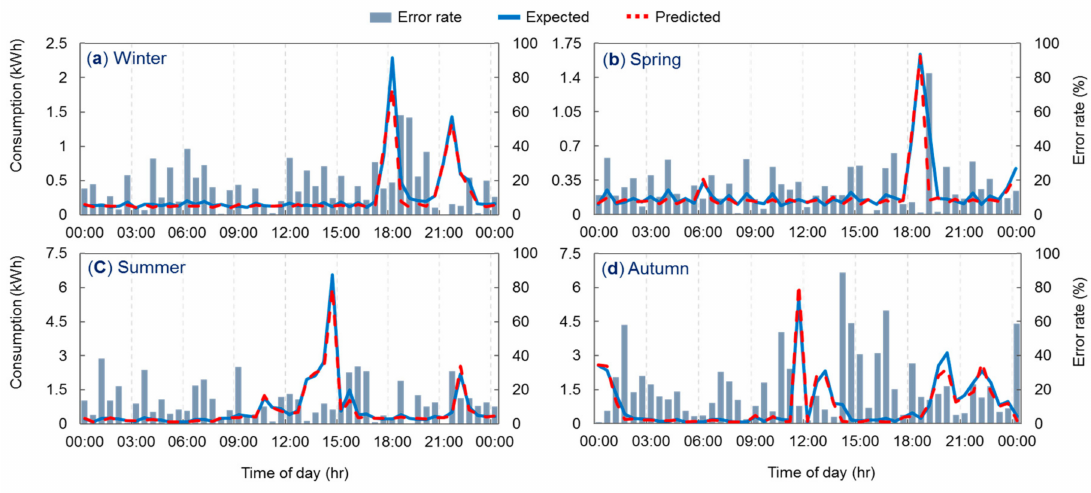
Figure 6. Comparison between the actual and predicted electricity consumption for the training results of ANN2 for a typical day in four seasons: ( a ) winter; ( b ) spring; ( c ) summer; and ( d )